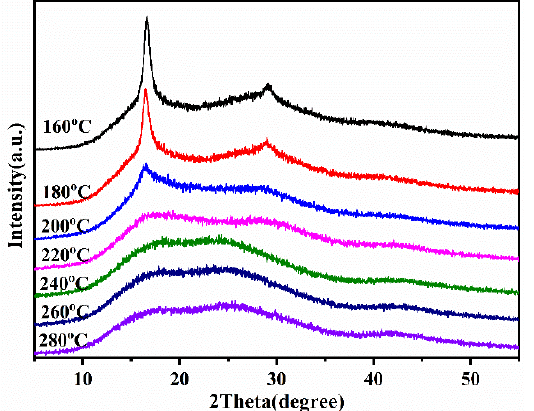
Figure 10. XRD patterns of P (AN- co -MLA) copolymers with mass feed ratio of AN/MLA = 97/3 (wt/wt) at various temperatures for 30 min.